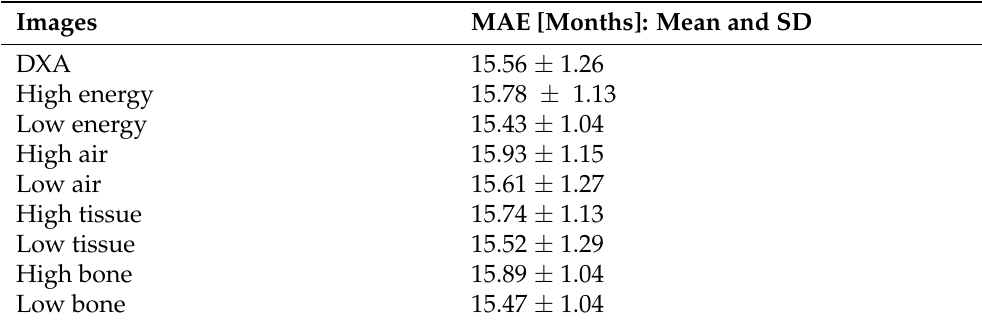
Table 5. Mean values and standard deviations of MAE obtained in Experiment IV—MobileNetV2 DW, different images.